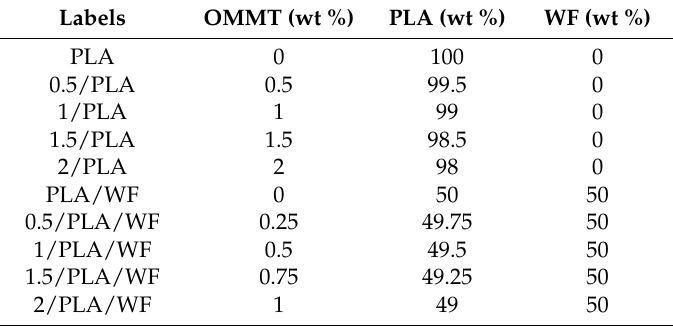
Table 1. Composition and labeling of the studied